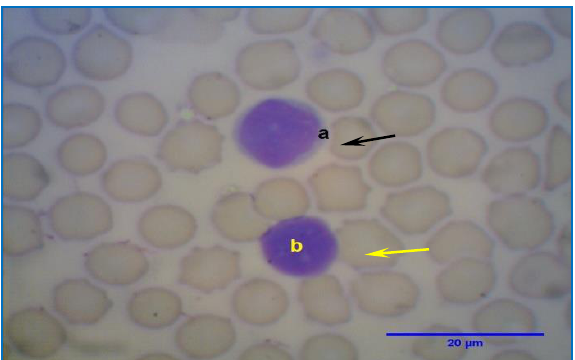
Figure, 8: (a) Peripheral band cytoplasm of medium-sized lymphocyte, (b) Small-Sized Lymphocyte (100x × 1.3 megapixels).